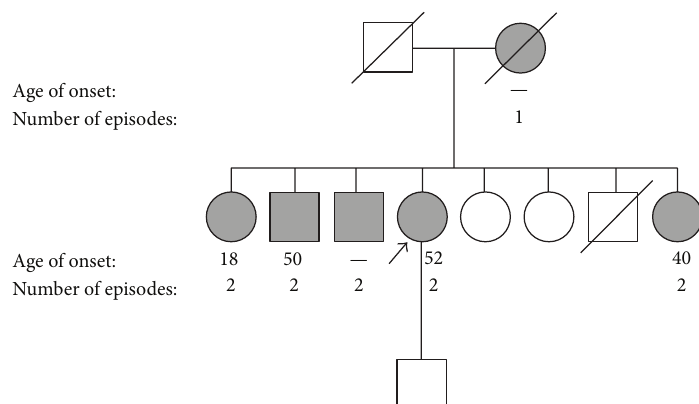
Figure 1: Pedigree . The patient is indicated by an arrow and all relatives that exhibited at least one episode of extreme facial pain are in grey. The age of onset and number of episodes are indicated beneath each affected